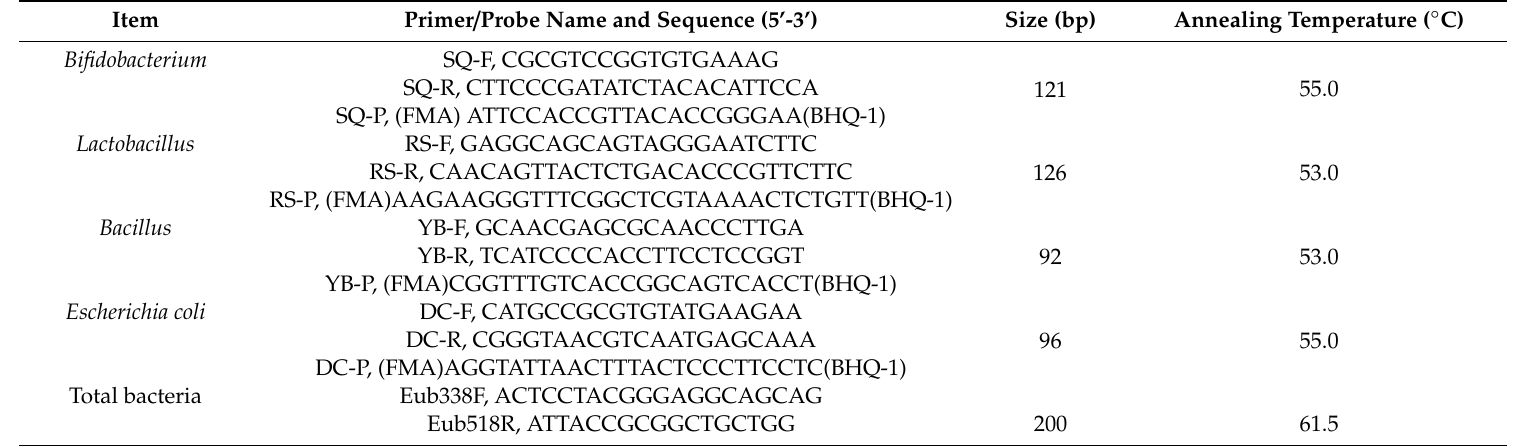
Table 3. Primer and probe sequences used for real-time quantitative PCR analysis of selected microbial populations in cecal digesta